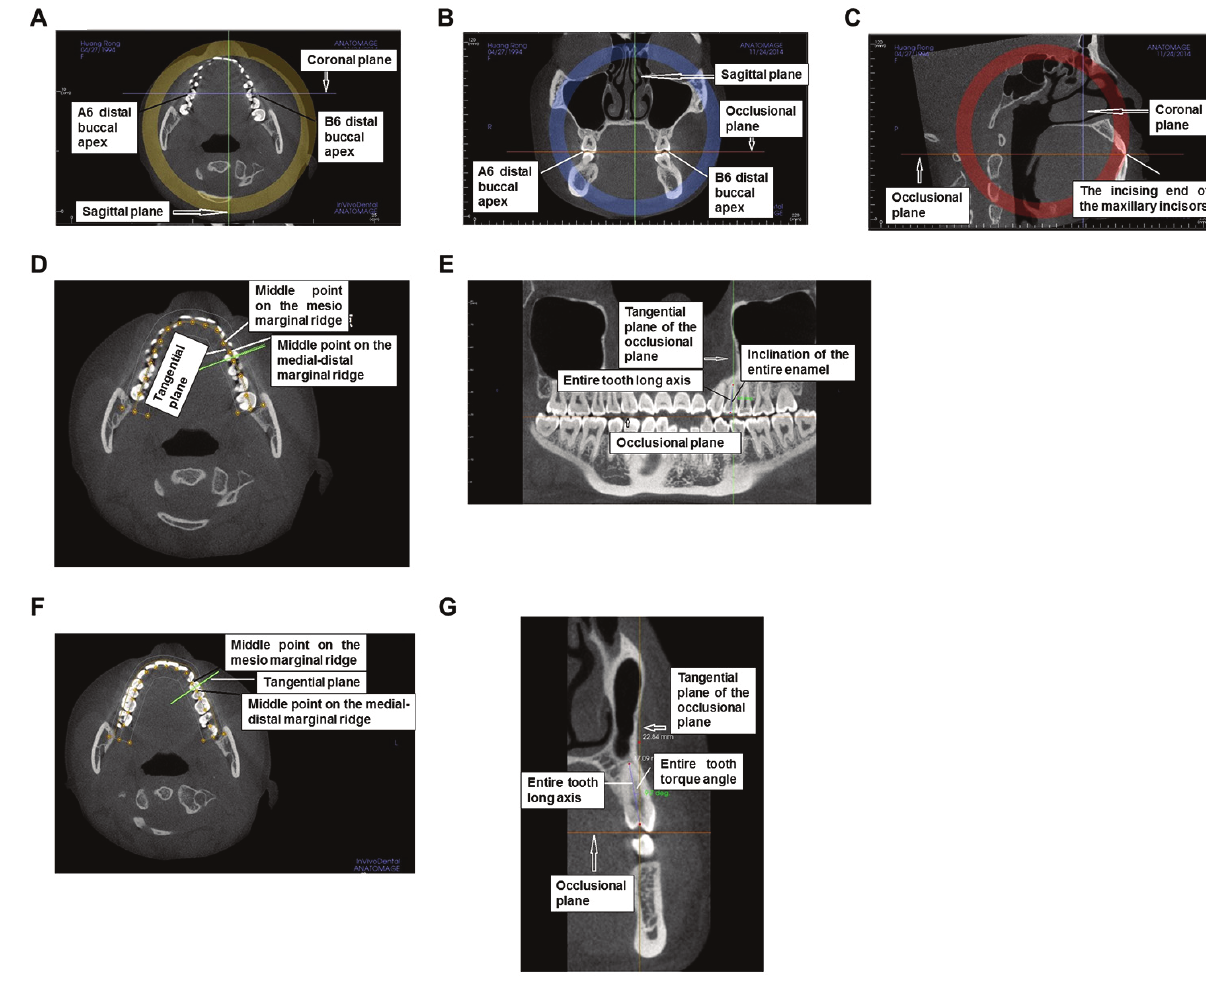
Figure 1: Adjustment of the base position for the craniofacial metrics plane. (A) Axial plane. (B) Coronal plane. (C) Sagittal plane. (D) Deter- mination of the tangential plane on the measured tooth. (E)Measurement of the coronal axial inclination in the entire tooth mesiodistal transverse plane. (F) Determination of the tangential plane on the measured tooth. (G) Measurement of the coronal torque angle in the entire tooth buccal (labial) lingual transversal